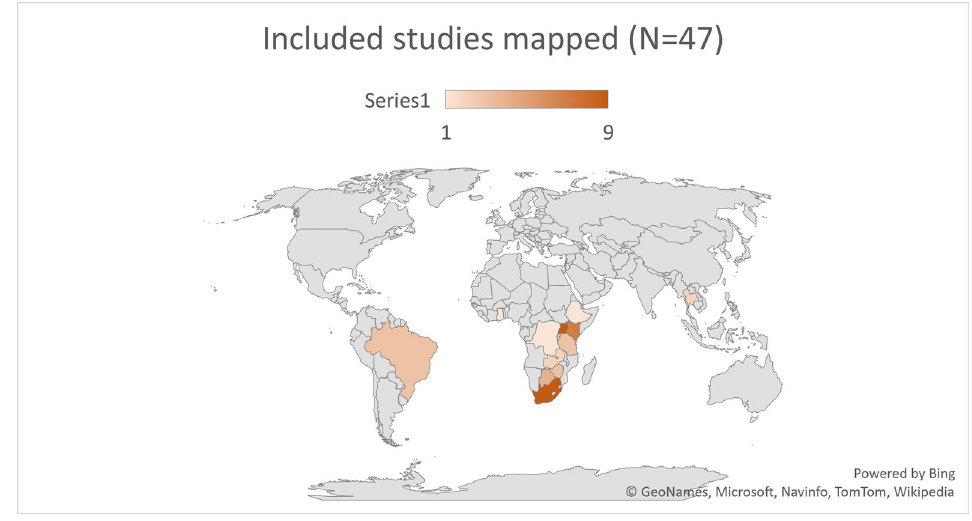
Figure 5: Included countries mapped